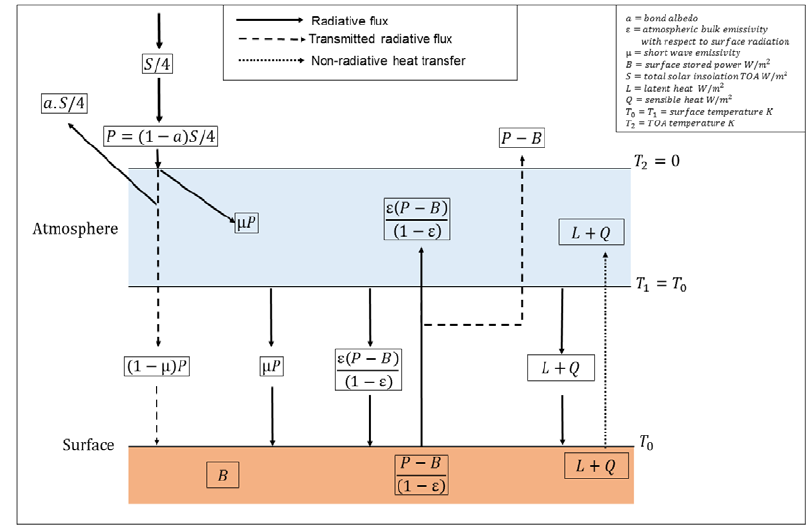
Figure 4. Non-equilibrium adiabatic radiative model with fluxes given as functions of P , ε , µ , B , L & Q . All of the units are in W/m 2 , except temperatures T 0 , T 1 , T 2 , which are in